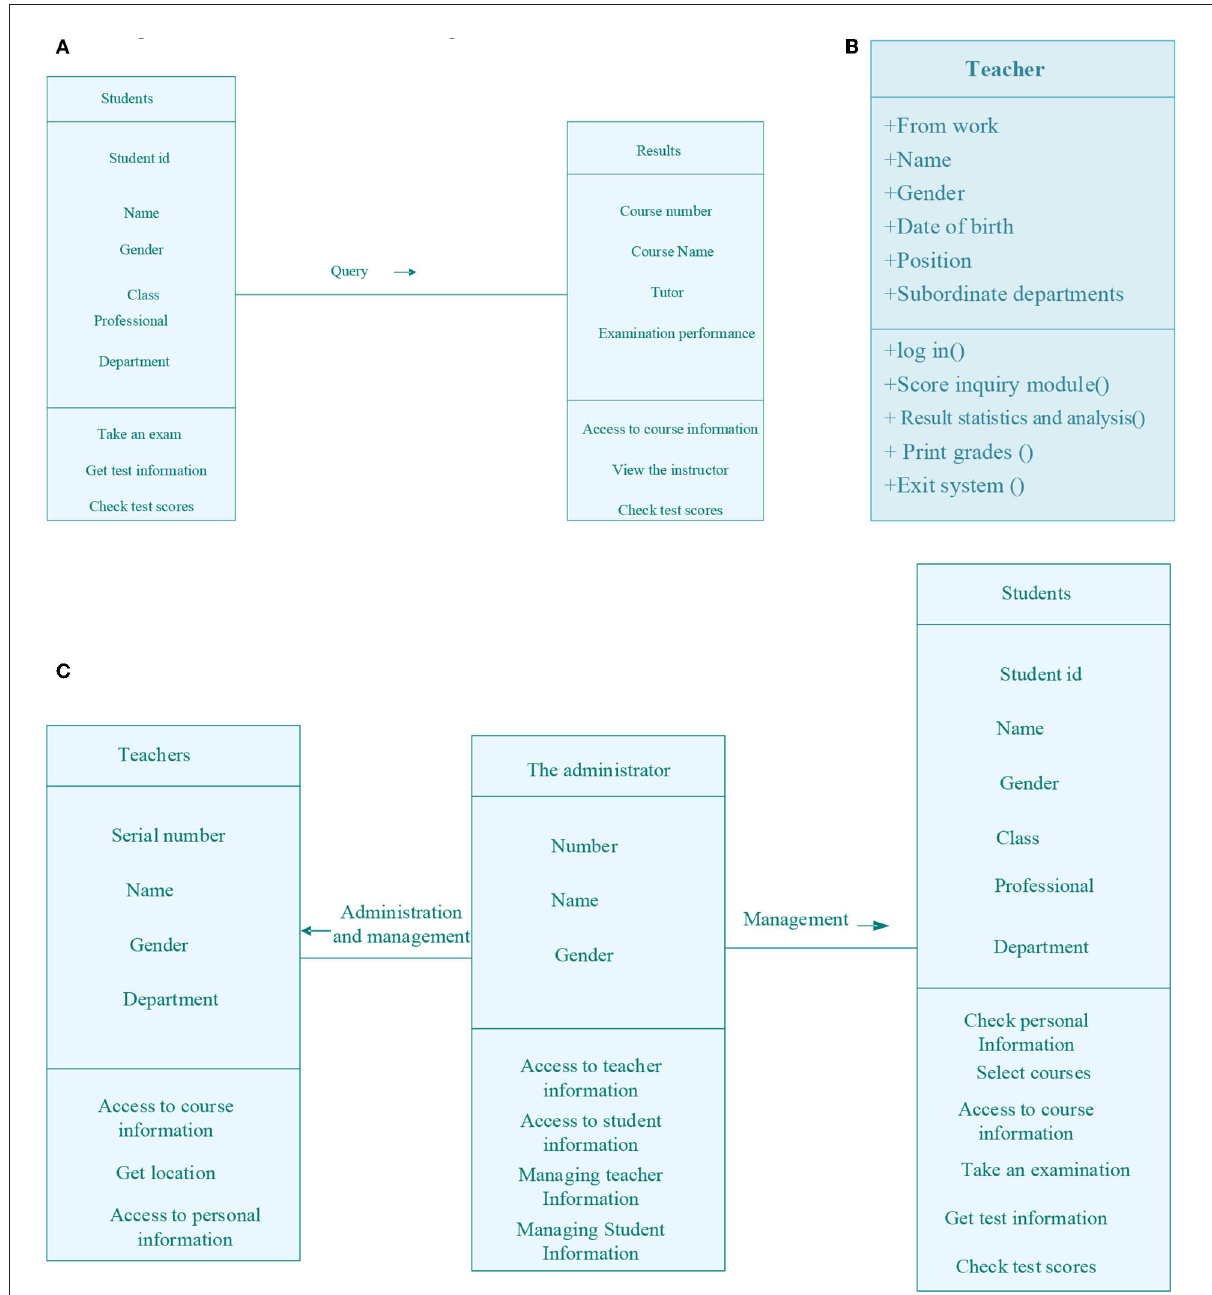
FIGURE6 Schematic diagram of micro-video management function. (A) Class diagram of students’ achievements management; (B) Class diagram of teachers’ information; (C) Class diagram of administrator